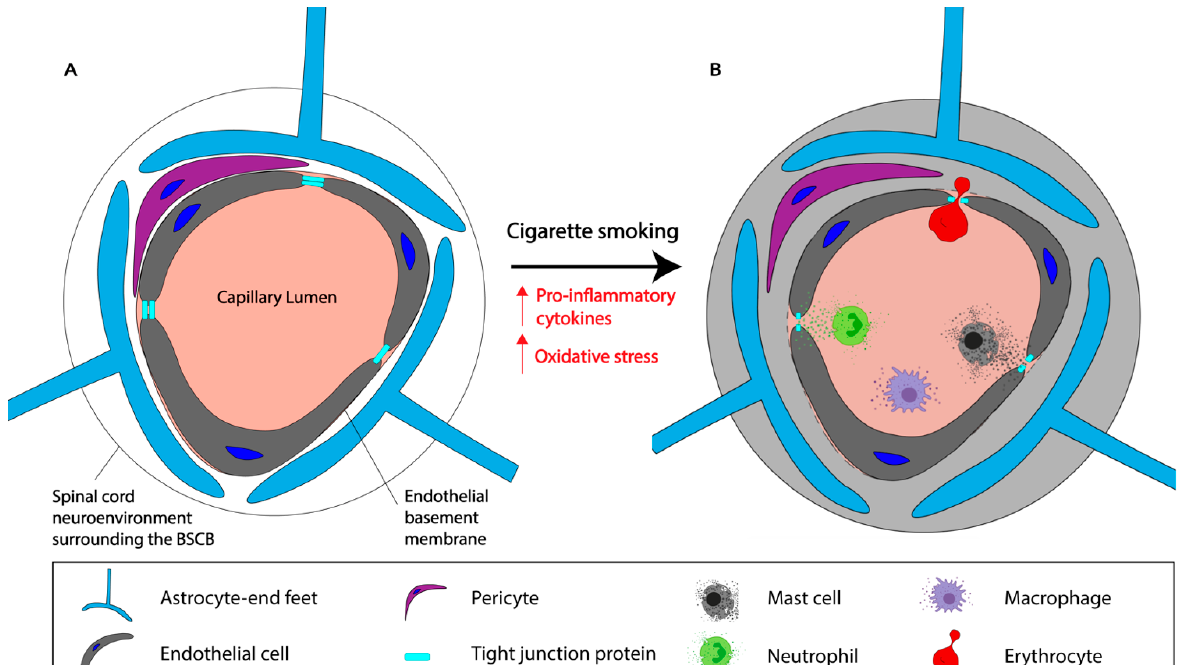
Figure 1. Proposed mechanism of direct blood–spinal cord barrier (BSCB) disruption caused by cigarette smoking. ( A ) Normal BSCB components including endothelial cells, tight junction proteins, pericytes and astrocytic end feet processes. ( B ) Cigarette smoke induced BSCB damage through oxidative and inflammatory processes. Leukocytes such as mast cells, macrophages and neutrophils release inflammatory cytokines and subsequently reactive oxygen species (ROS) leading to an impairment and reduced expression of tight junction proteins. This facilitates further damage to BSCB components including disrupted astrocyte/pericyte-endothelial communication, modulated endothelial cell activity and endothelial basement membrane disruptions. Here, a neurotoxic environment surrounding the BSCB is established and maintained by the constant influx of inflammatory cytokines and ROS from leukocytes, resulting in further BSCB damage.